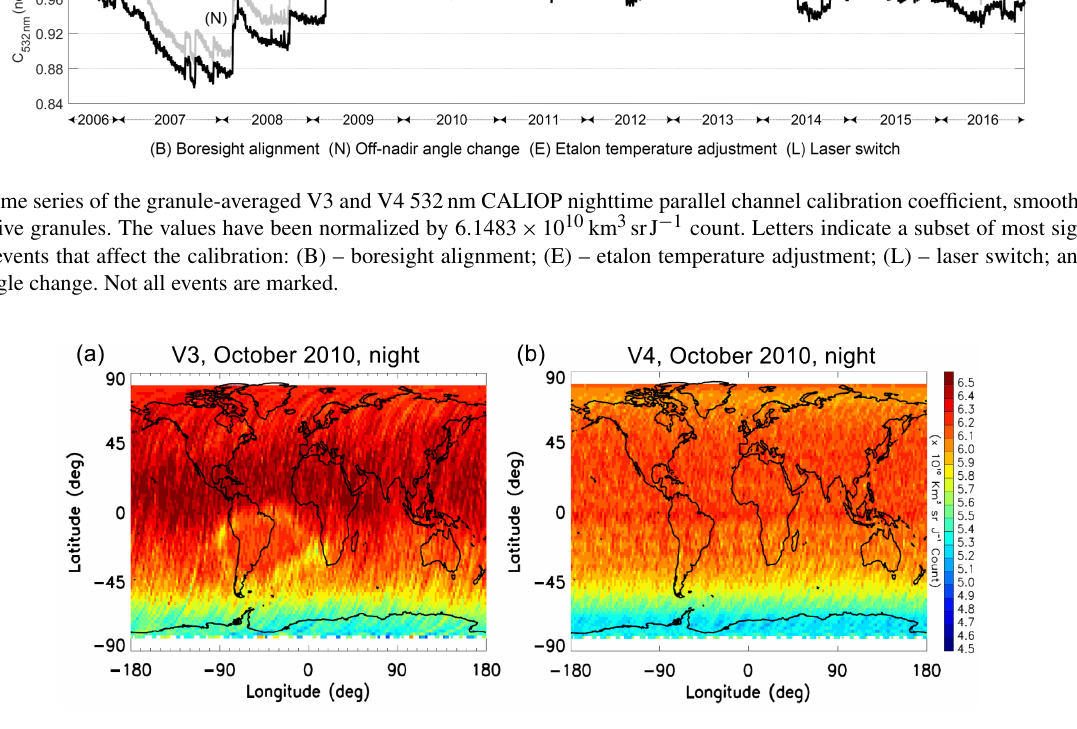
regions. This is on the same order of uncertainty as in